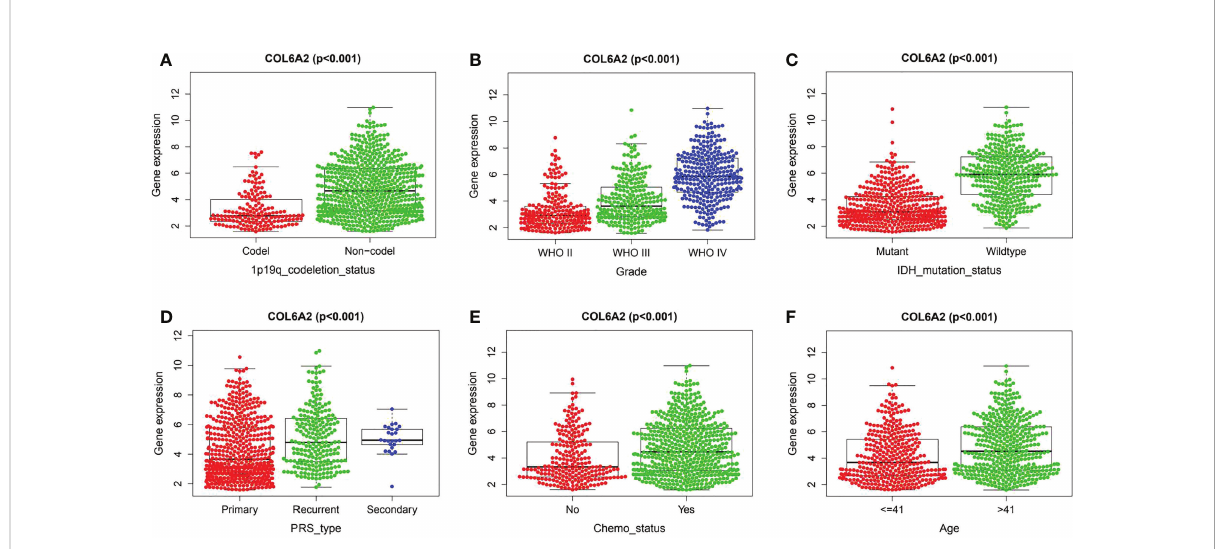
FIGURE 5 Correlation between COL6A2 expression and clinical traits in CGGA. (A) the expression of COL6A2 has a signi fi cant correlation with 1p19q codeletion. (B) In WHO grade, COL6A2 expression was higher with the higher grade. (C) COL6A2 expression was signi fi cantly correlated